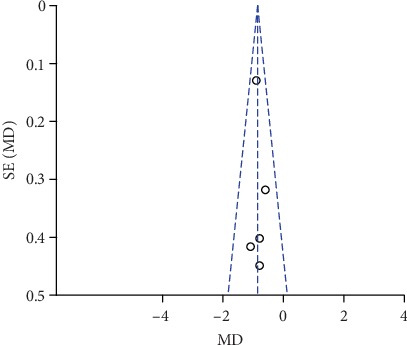
Funnel plot of pain scores at rest at 6 h.